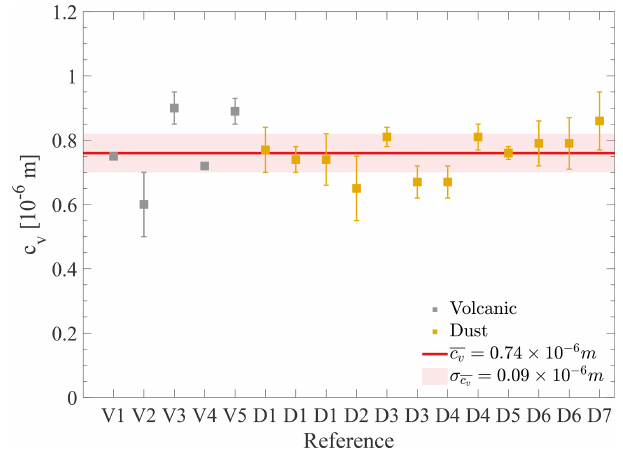
Figure 3. The scatter plot indicates the mean and the standard de- viation of the conversion factor, c v , for the different literature ref- erences. The plot is color coded with respect to “Volcanic” (gray) and “Dust” (orange) observations. The red line highlights the over- all mean conversion factor and the reddish-pink rectangle shows the standard deviation – i.e., ( 0 . 76 ± 0 . 06 ) × 10 − 6 m.